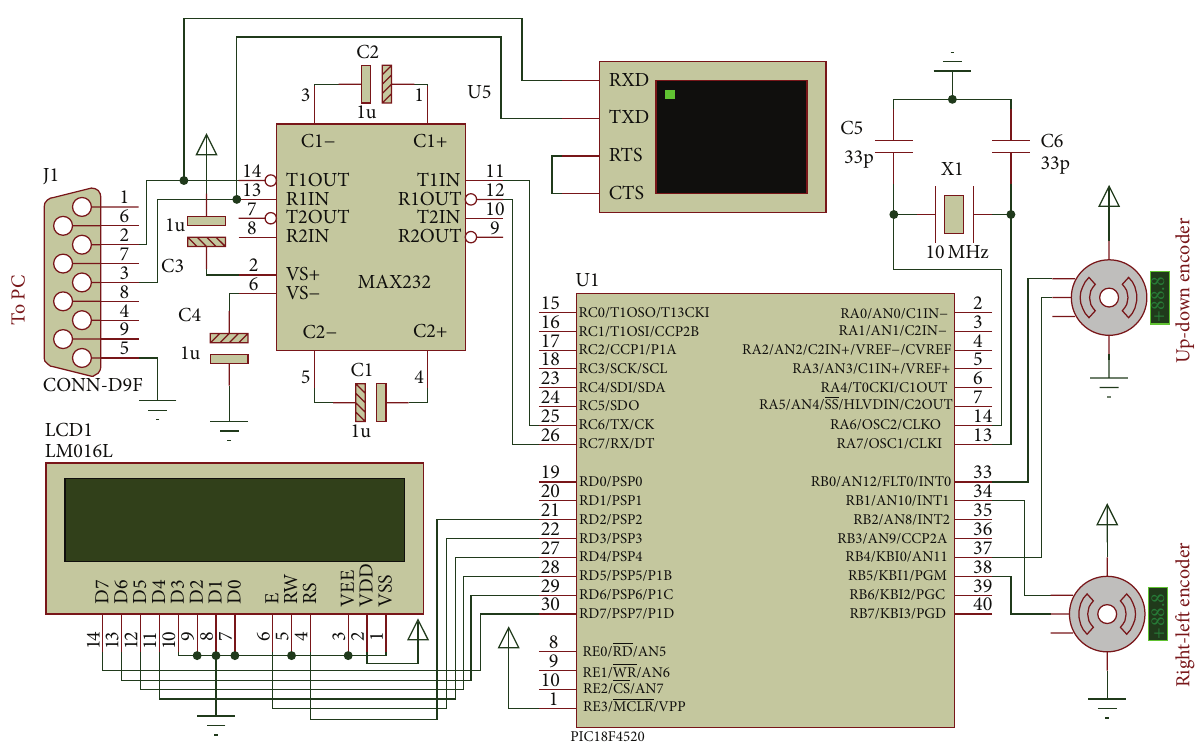
Figure 10: Implementation of open model for the proposed